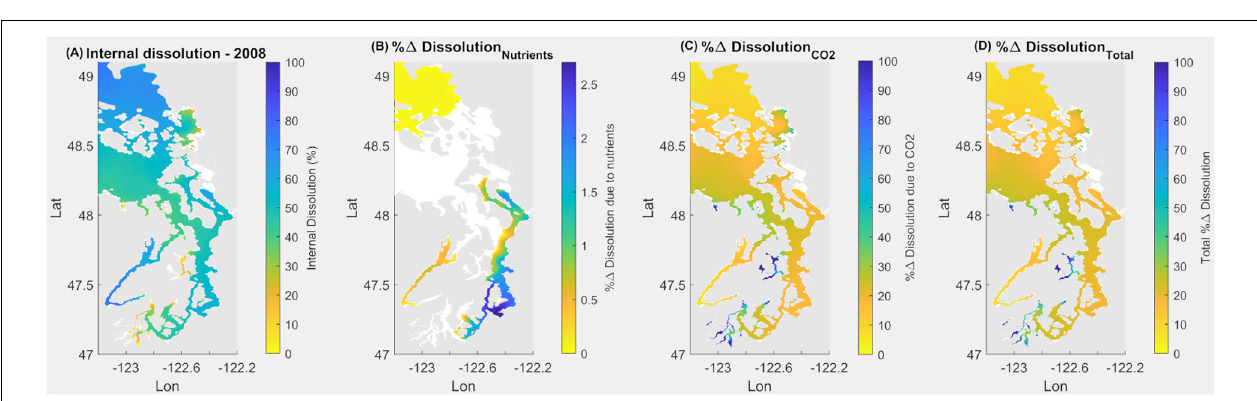
FIGURE 9 | Application of equation for larval Dungeness crab dissolution over upper 160 m integrated water depth for May–June in the Salish Sea to demonstrate current (2008) state of internal dissolution in % (A) ; % change of dissolution due to nutrients (B) ; due to atmospheric CO 2 (C) ; and combined % change due to both nutrients and atmospheric CO 2 (D)